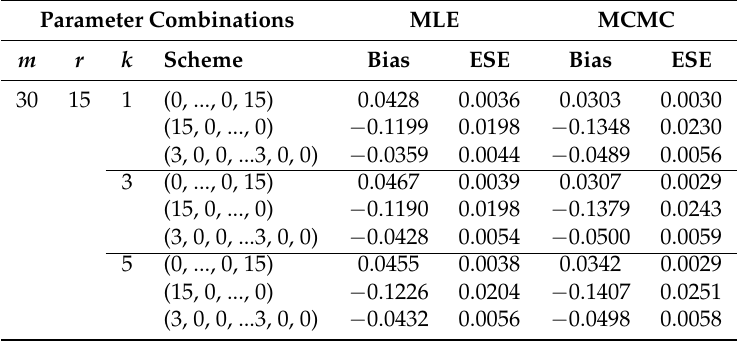
Table 6. The bias and ESEs of the MLEs and Bayes estimates of δ for ( α , β 1 , β 2 ) = ( 5,0.08,0.16 ) .